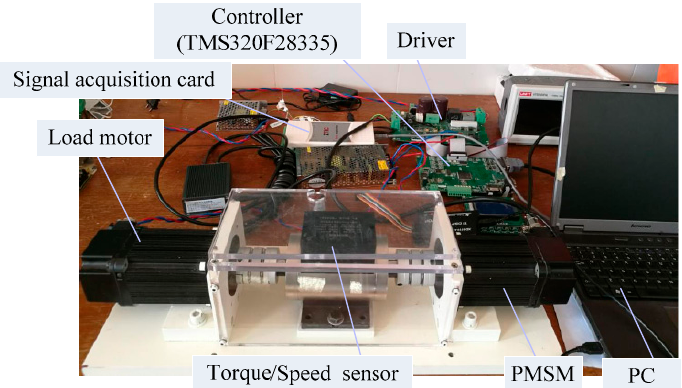
Figure 4. Experiment platform.